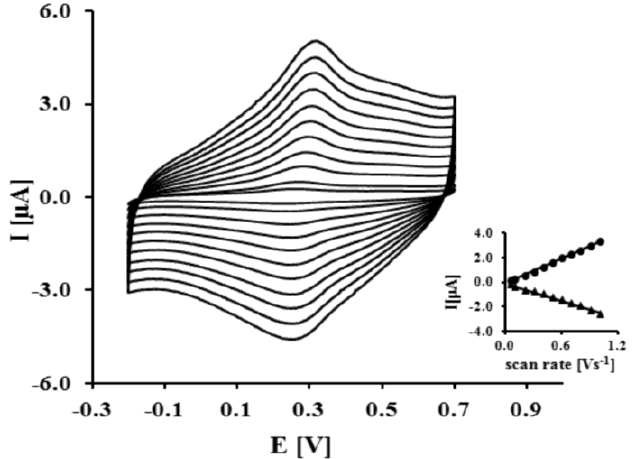
-RAGE V domain (dashed line); 6